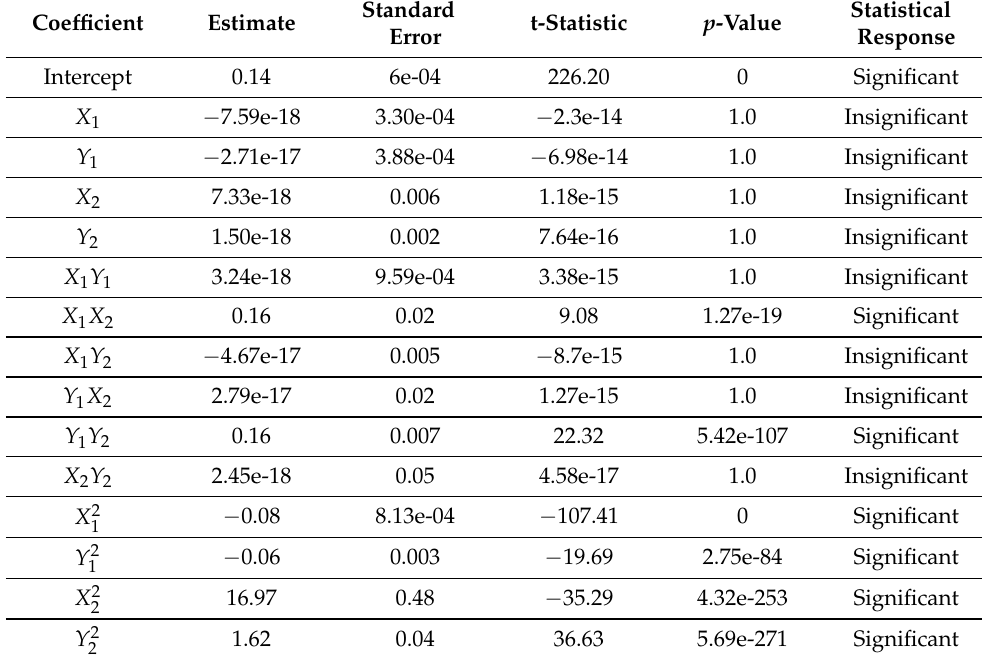
Table 3. Showing 4-angle hyperspectral BRDF model coefficients for 864 nm wavelength. Statistical Standard t-Statistic p -Value Coefficient Estimate Response Error Intercept 0.14 6e-04 226.20 0